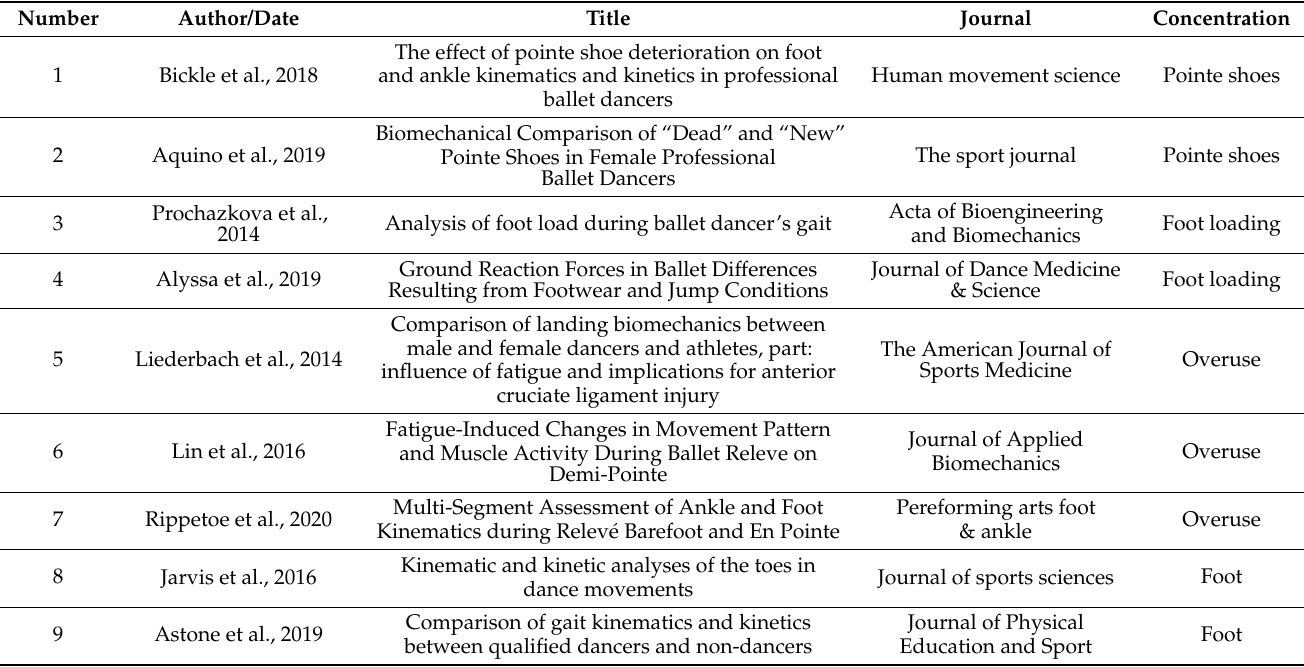
Figure 2. The detailed search strategy of the review. Table 1. Basic information of the included